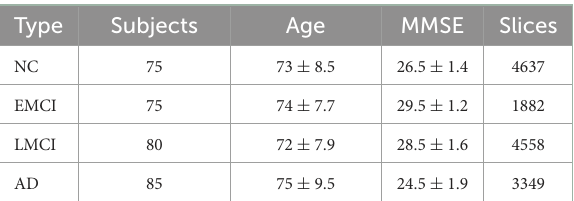
TABLE 1 Sample size of the dataset with specifications and number of subjects utilized for each